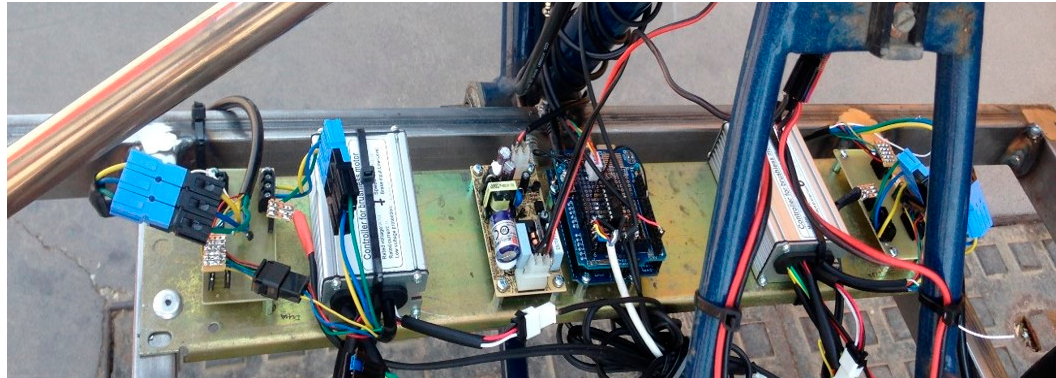
Figure 5. Two independent motor controllers and the hardware implementation of the CPU with an master unit generated with an Arduino ONE SMD R3 board. Each motor also presents an input current sensor.